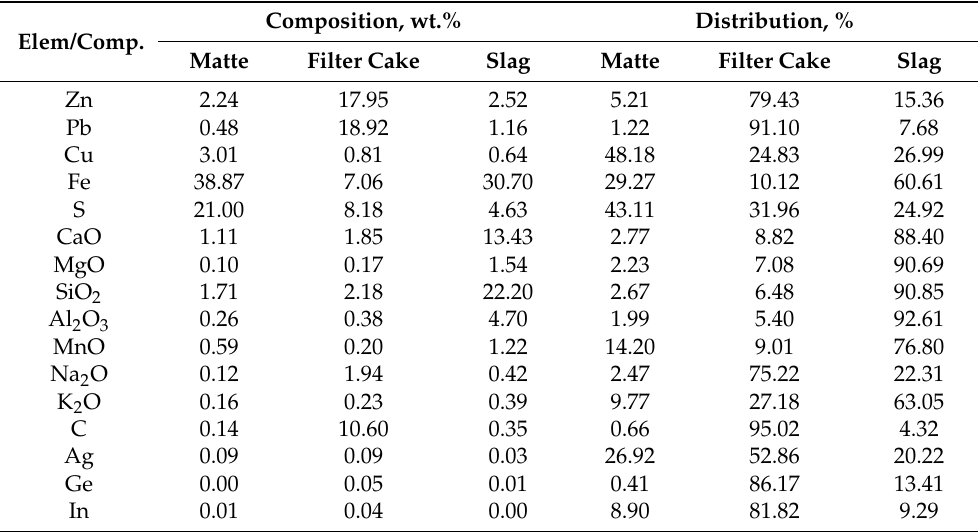
Table 8. Compositions and distribution coefficients of final products of the submerged plasma process. Composition, wt.% Distribution, % Elem/Comp. Matte Filter Cake Slag Matte Filter